Question: Reading the figure, is the described quantity rising or falling?
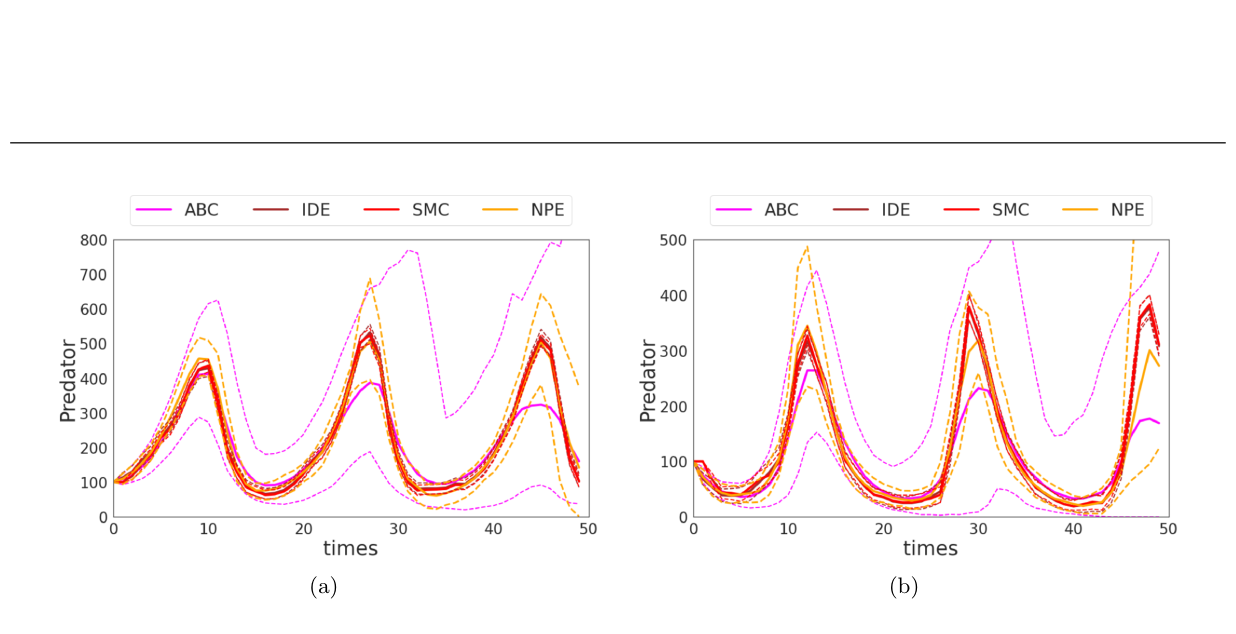
Answer: decreasing